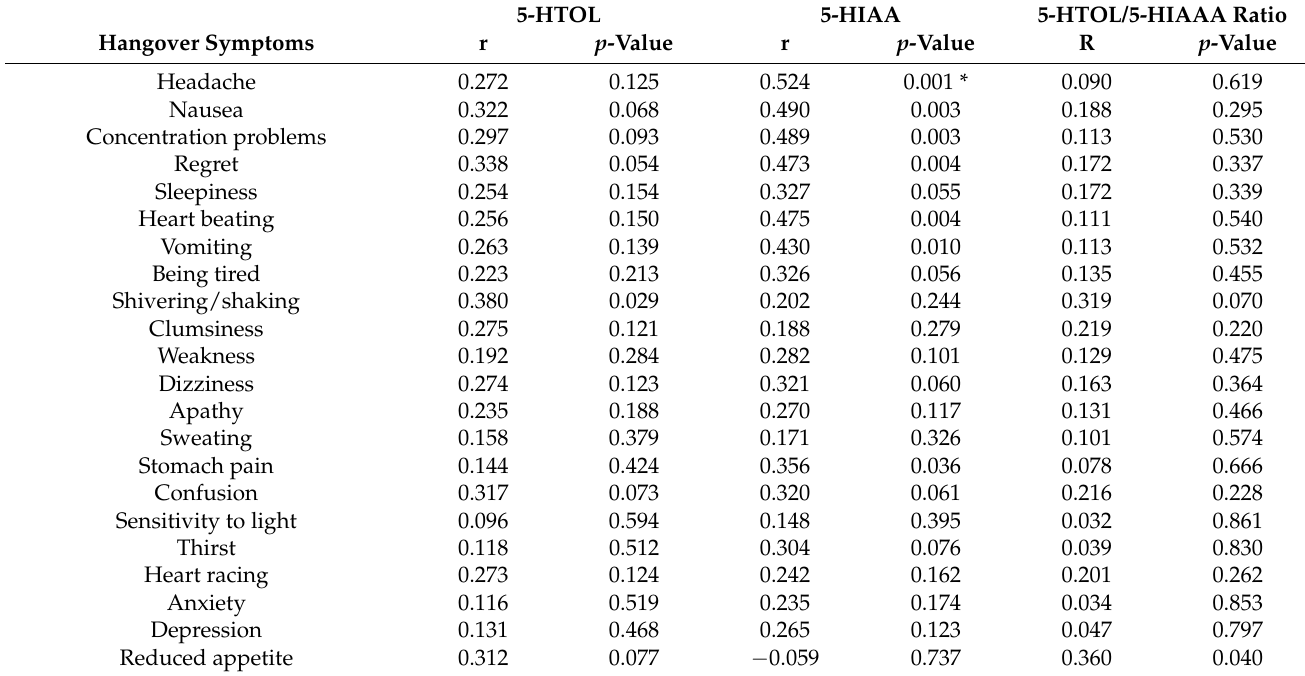
Table 5. Correlations between biomarkers and the severity of individual hangover symptoms on the alcohol